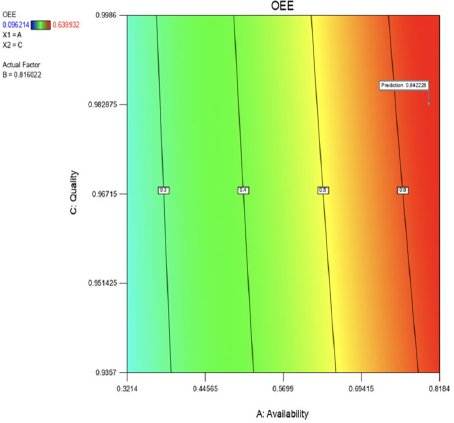
Fig. 7. Desirability contour plot – Quality vs Availability Fig. 8. OEE contour plot – Quality vs Availability